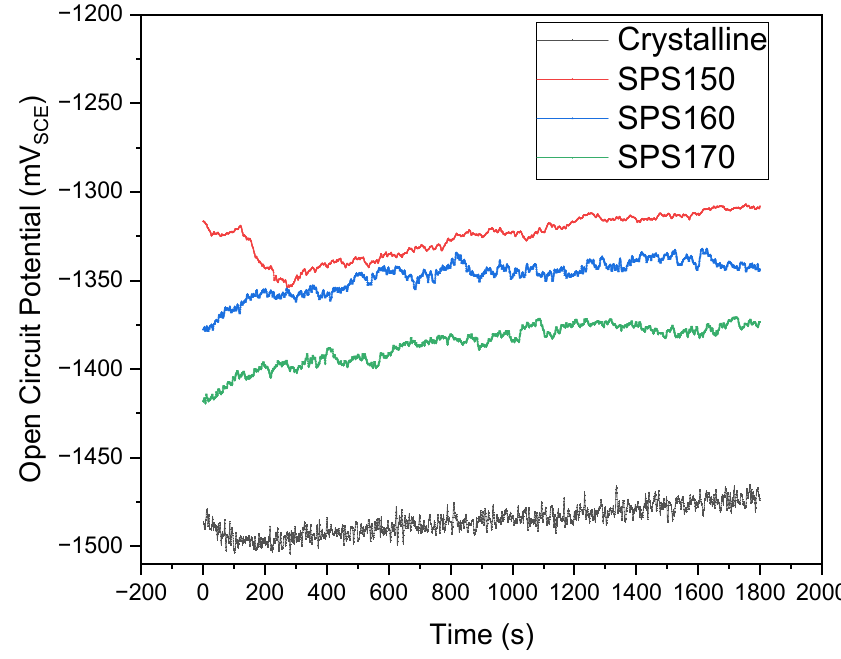
Figure 7. Time dependence open circuit potential (OCP) across various sintering temperatures compared to as-cast.